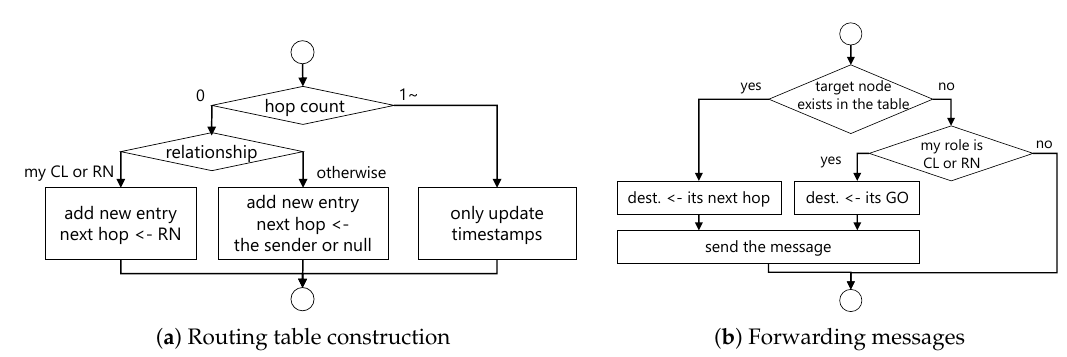
Figure 6. Flowchart of multi-hop communication mechanism.